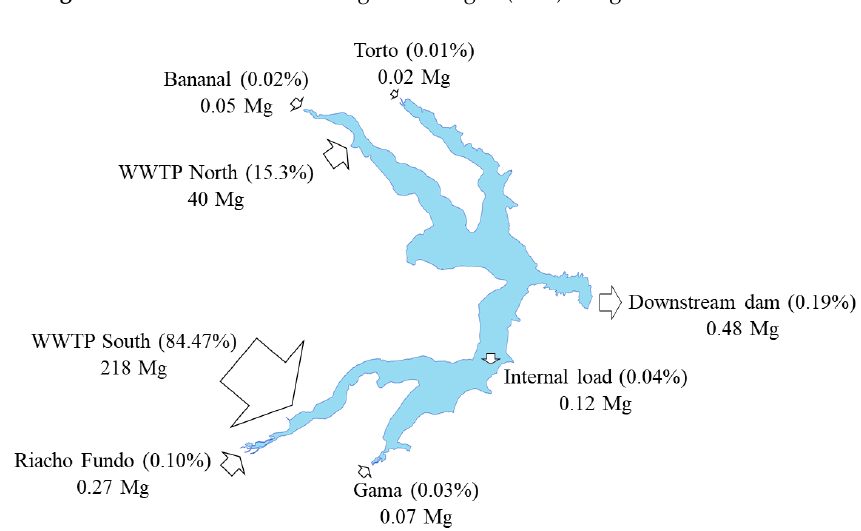
Figure 7. Annual total organic phosphorus (TOP) budget for Lake Paranoá.